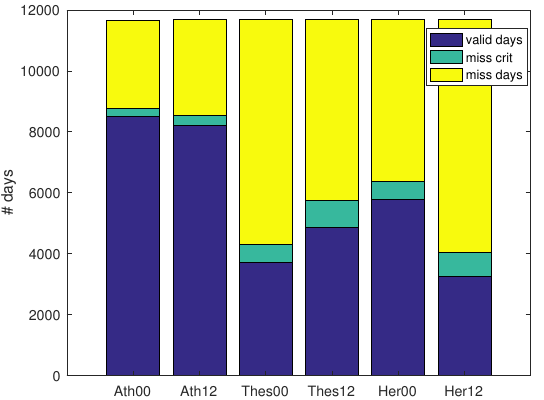
Figure 2. Available data for all sites and times of observations. Shown are the number of available days, the number of missing days and the number of excluded days due to the quality criteria described in Section